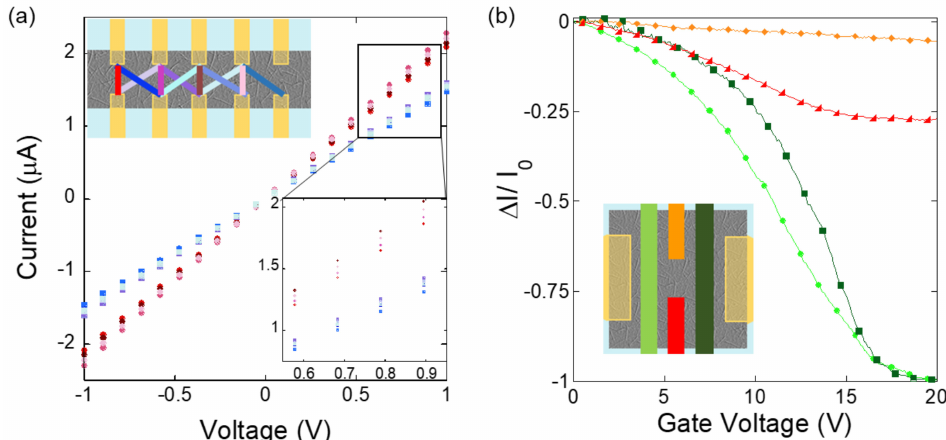
Figure 5. ( a ) Current voltage measurements for ten electrode CNT thin film devices. The device geometry is shown in the inset. The colored lines between electrodes indicate the electrode pairings and are color-coded to associated data in the graph. Vertical electrodes are spaced 20 µ m apart, and neighboring electrodes are 30 µ m apart from center to center. ( b ) Normalized current change as a function of gate voltage for a different device with two electrodes and four independent top gates. The inset shows the device geometry with gates color coded to match the data, and source and drain electrodes shown in gold. The distance between source and drain electrodes is 60 µ m, and the nearest gates from the electrodes is 8 µ m. Left and right gates each cover a 60 µ m × 10 µ m region of the channel, while middle gates each cover a 20 µ m × 10 µ m